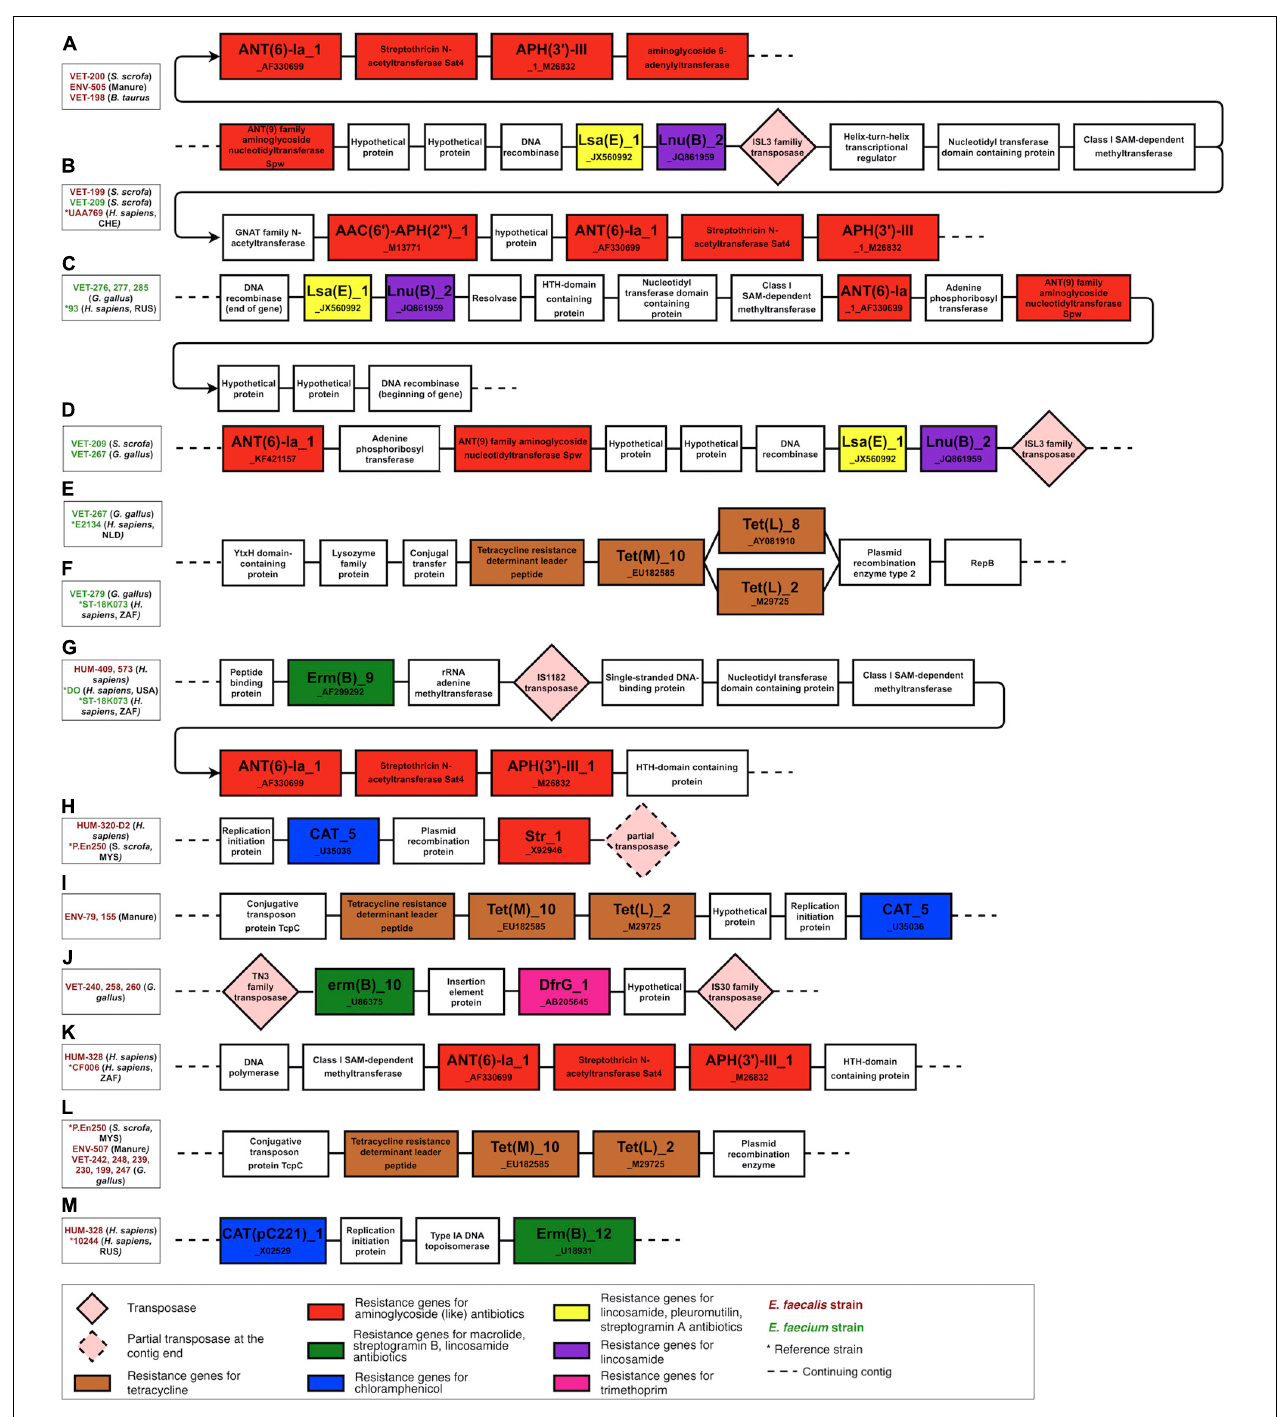
FIGURE 4 | The genomic context of the resistance genes in the antibiotic resistance islands. Most of the clustered resistance genes were found in the same genetic context in strains of different origins and were flanked by mobile genetic elements and plasmid-related genes. The figure illustrates only the context and is not scaled to the actual length of the genes and intergenic sequences. (A–D) a lsa(E) , lnu(B) and aminoglycoside resistance genes harboring genomic islands found in husbandry and human related strains, (E,F,L) a tetracycline resistance gene cluster variants found in human and husbandry related strains, (G) a erm(B) and aminoglycoside resistance genes harboring genomic in human related strains, (H) a cat_5 and str_1 genes harboring genomic island in human and husbandry related strains, (I) a tetracycline resistance cluster and cat_5 gene harboring genomic island found in husbandry related strains, (J) a erm(B) and dfr(G) genes harboring genomic island found in poultry related strains, (K) an aminoglycoside resistance genes harboring genomic island found in human related strains, (M) cat(pc221)_1 and erm(B) genes harbouring genomic island found in human related strains.